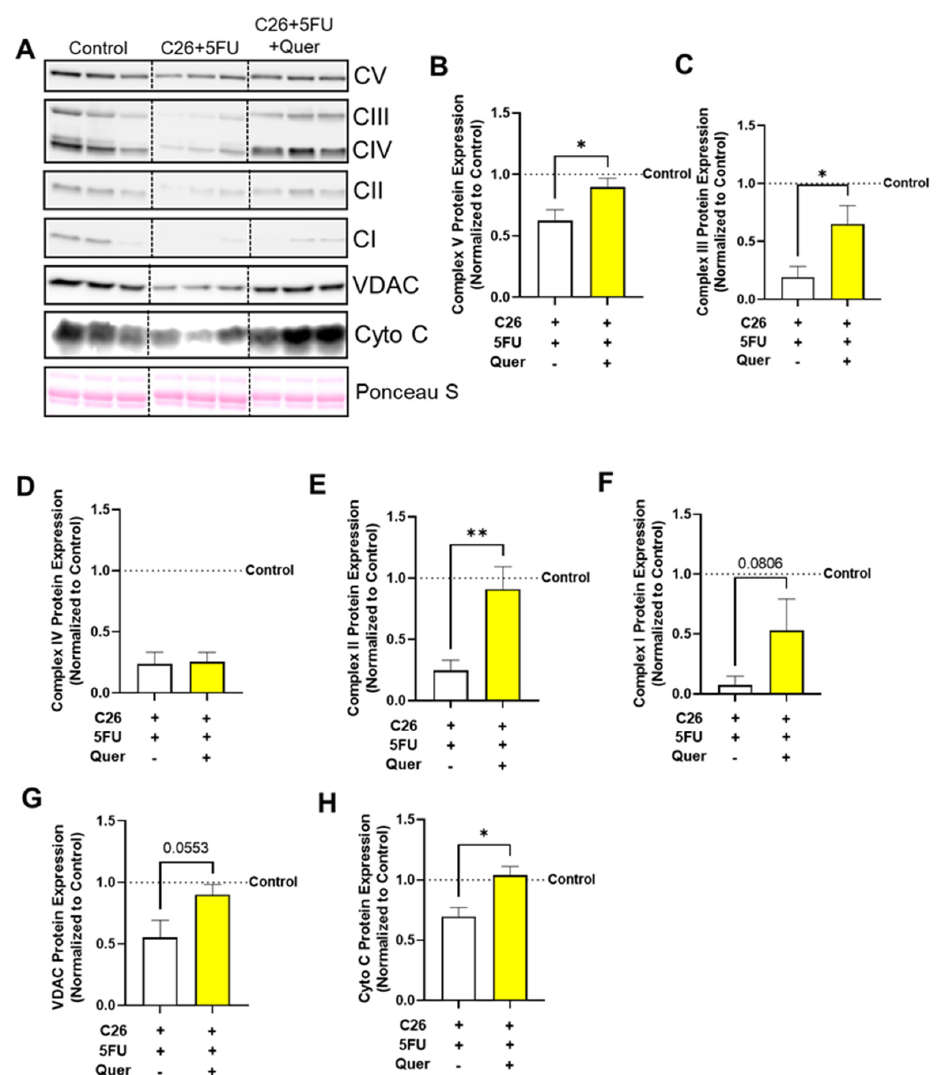
Figure 4. Quercetin increased mitochondrial content proteins. ( A ) Representative Western blots of mitochondrial complexes I-V, voltage dependent anion channel (VDAC), cytochrome c (Cyto C), and loading control Ponceau S from the rectus femoris muscle. Vertical dotted line demonstrates where images were cropped for representation. All samples were run on the same gel/membrane. Quantified relative expression of ( B ) Complex V, ( C ) Complex III, ( D ) Complex IV, ( E ) Complex II, ( F ) Complex I, ( G ) VDAC, and ( H ) Cyto C. Unpaired t ‐ test between C26 + 5FU and C26 + 5FU + Quer. n = 3 – 5/group. * p ≤ 0.05, ** p <